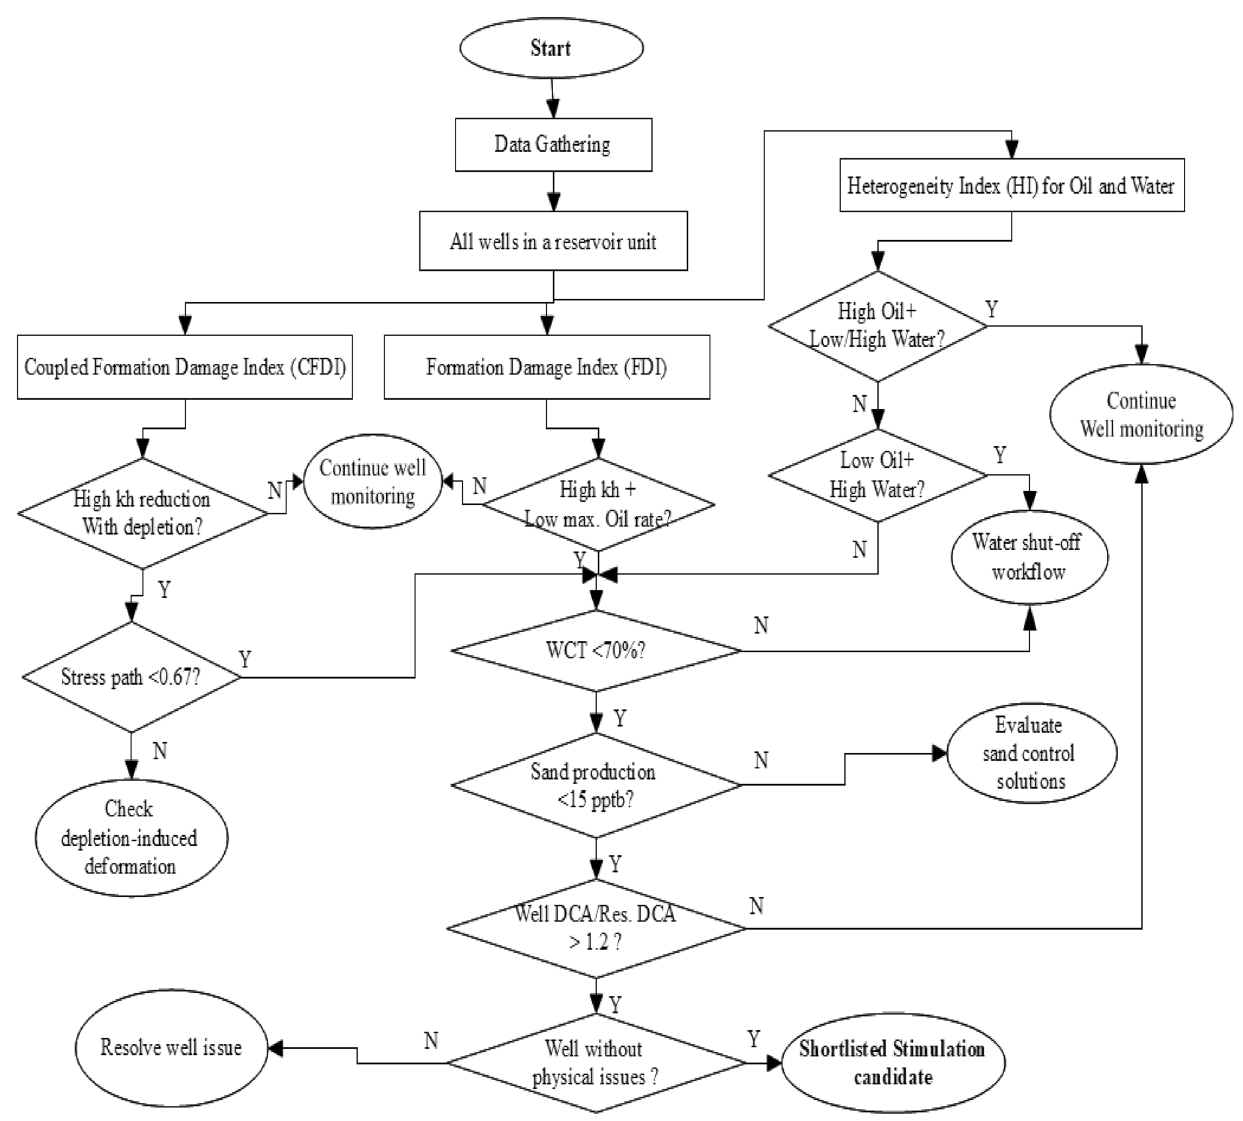
Fig. 2 Proposed candidate selection